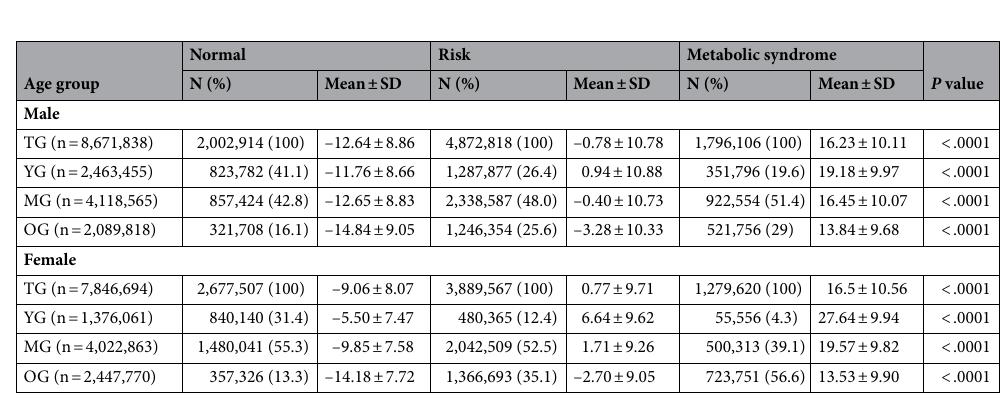
Table 4. Clinical applications of the developed MS BA model. Young group: 20.0 ≤ Age < 40.0 years, Middle group: 40.0 ≤ Age < 60.0 years, Old group: Age ≥ 60.0 years. TG total group, YG young group, MG middle group, OG old group, SD standard